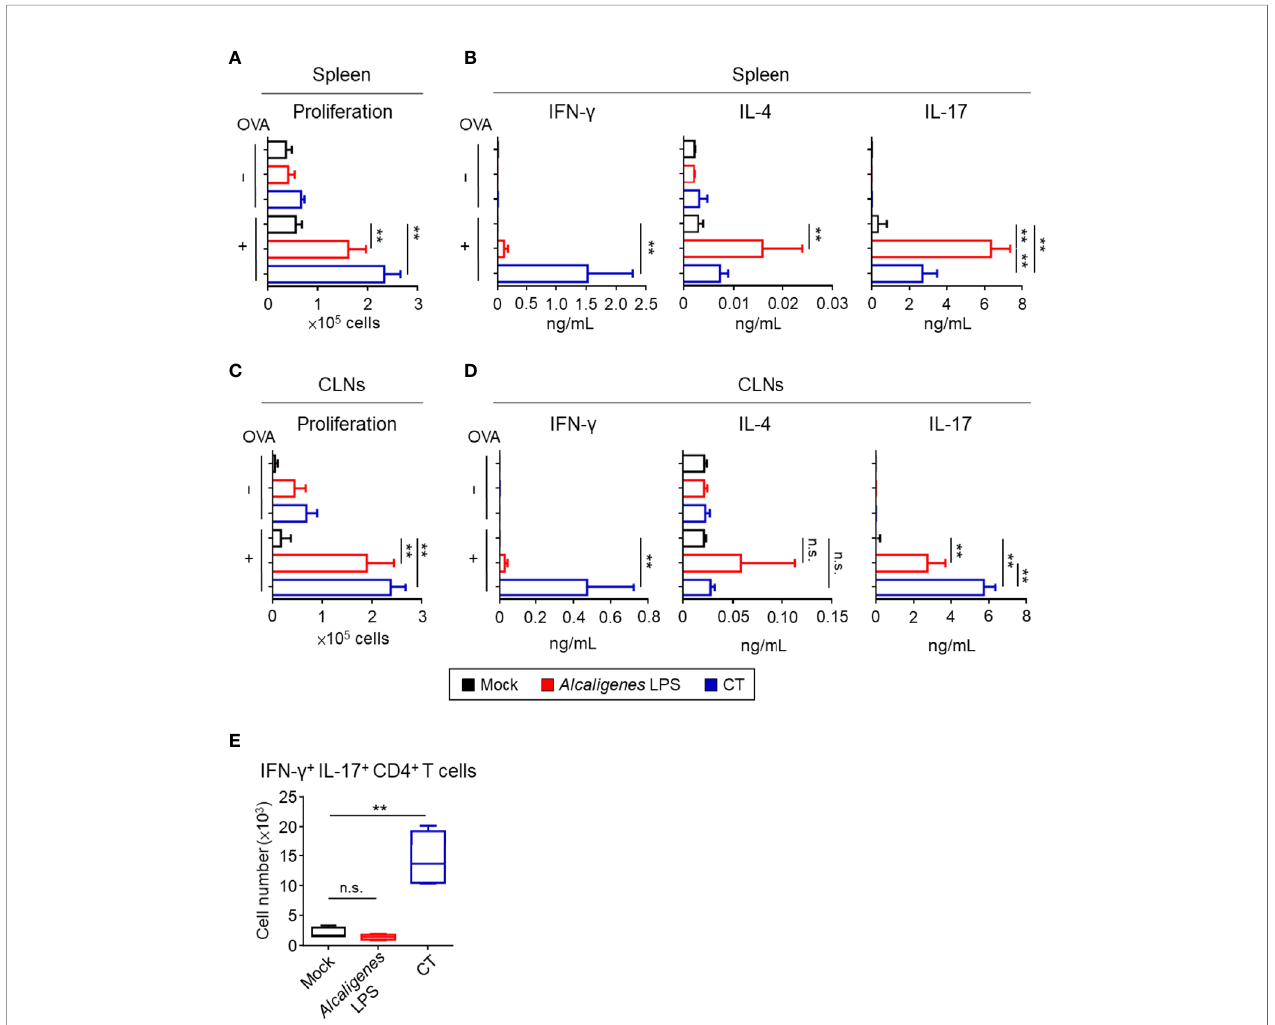
FIGURE 4 | Alcaligenes LPS promotes OVA-speci fi c Th17 response. Mice were nasally immunized three times with OVA alone (Mock) or with OVA plus Alcaligenes LPS or CT; one week after the fi nal immunization, splenic or CLNs CD4 + T cells were collected and stimulated with OVA by ex vivo . (A) Proliferation of splenic CD4 + T cells was determined by CyQUANT ® Cell Proliferation Assays Kits and fl uorescence microplate reader, ARVO X2 with measuring at 485/535 nm. (B) Production of cytokines: IFN- g , IL-4 and IL-17A in the supernatant of splenic CD4 + T cell culture was collected and measured by the CBA kit. (C) Proliferation of CLNs CD4 + T cells. (D) Production of cytokines: IFN- g , IL-4 and IL-17A in the supernatant of CLNs CD4 + T cell culture. (E) Number of IFN- g + IL-17 + CD4 + T cells (gated on: zombie − CD45 + TCR- b + CD4 + IFN- g + IL-17 + ) in spleen were analyzed by intracellular cytokine staining and fl ow cytometry ( n = 6 per group). Data are representative of two independent experiments and were analyzed by one-way ANOVA (** p < 0.01; n.s., not signi fi